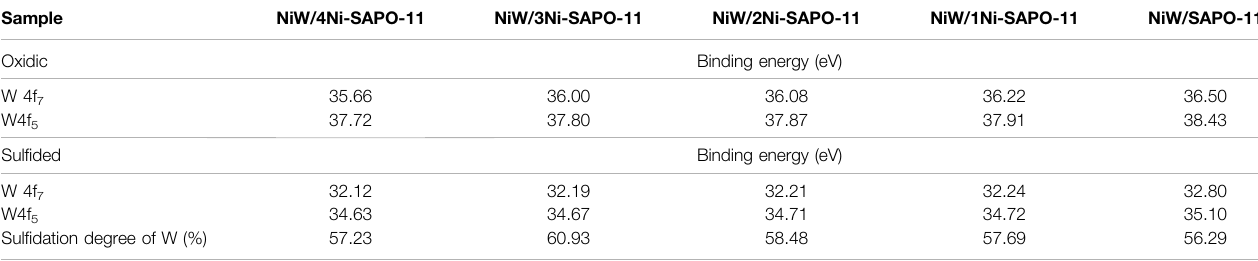
TABLE 5 | Binding energy and sul fi dation degree of W on different catalysts. Sample